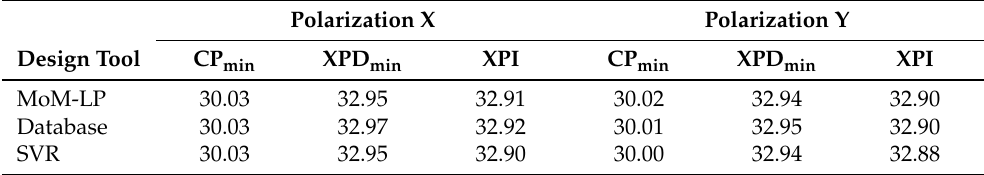
Table 2. Figures of merit of a European coverage pattern when the design is carried out using different tools and simulated with MoM-LP. CP min is in dBi and XPD min and XPI are in